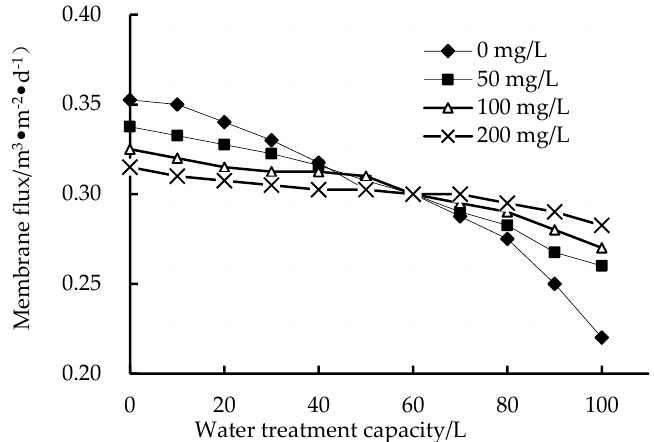
Figure 2. Effect of PAC dosage on the